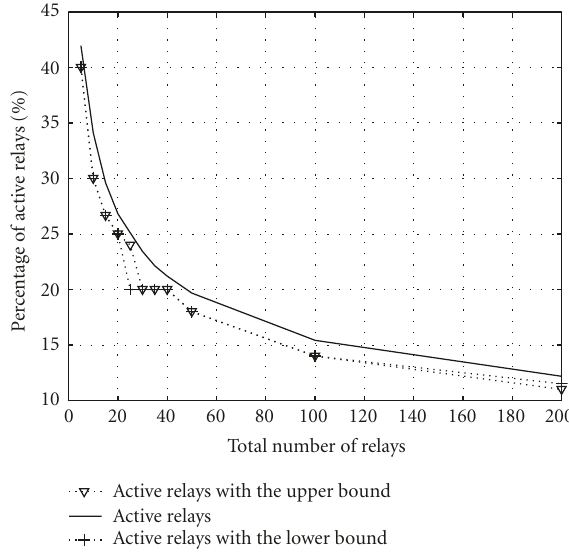
Figure 7: Expected number of active relays (in %) of a multiple relay channel with transmit SNR = 10 dB, under Rayleigh fading. The number of relays that optimizes the upper and lower bounds are shown for